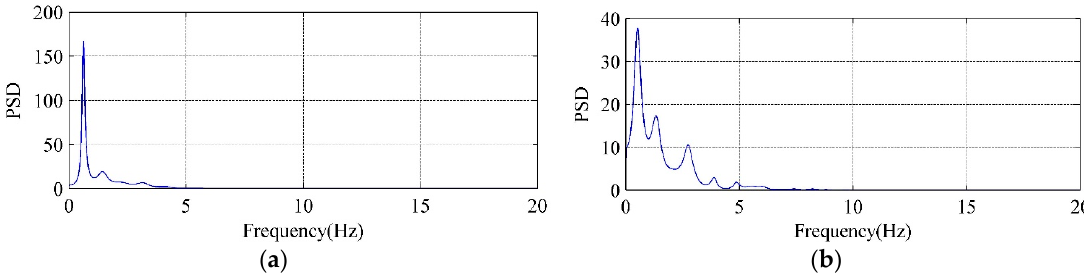
Figure 7. Comparisons of the PSD curves of LFN observed at T9: ( a ) Condition 2; ( b ) Condition 6.